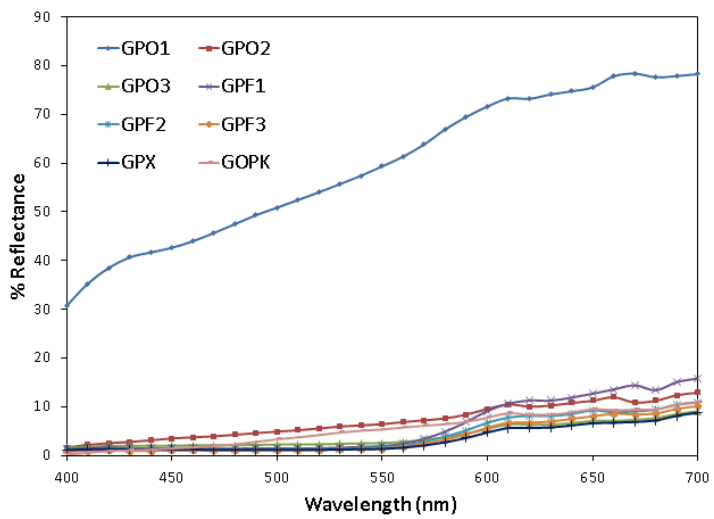
Figure 11. Dependence of the reflectance (%) on the wavelength (nm) for all prepared glazes fired at 1060 °C.